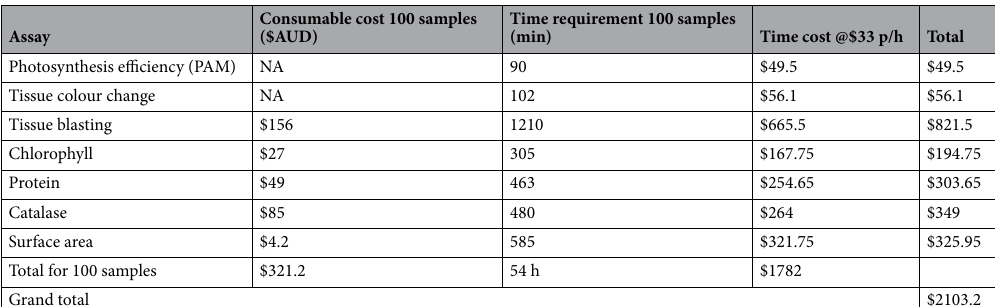
Table 1. Cost of consumables and time requirements for each assay to process 100